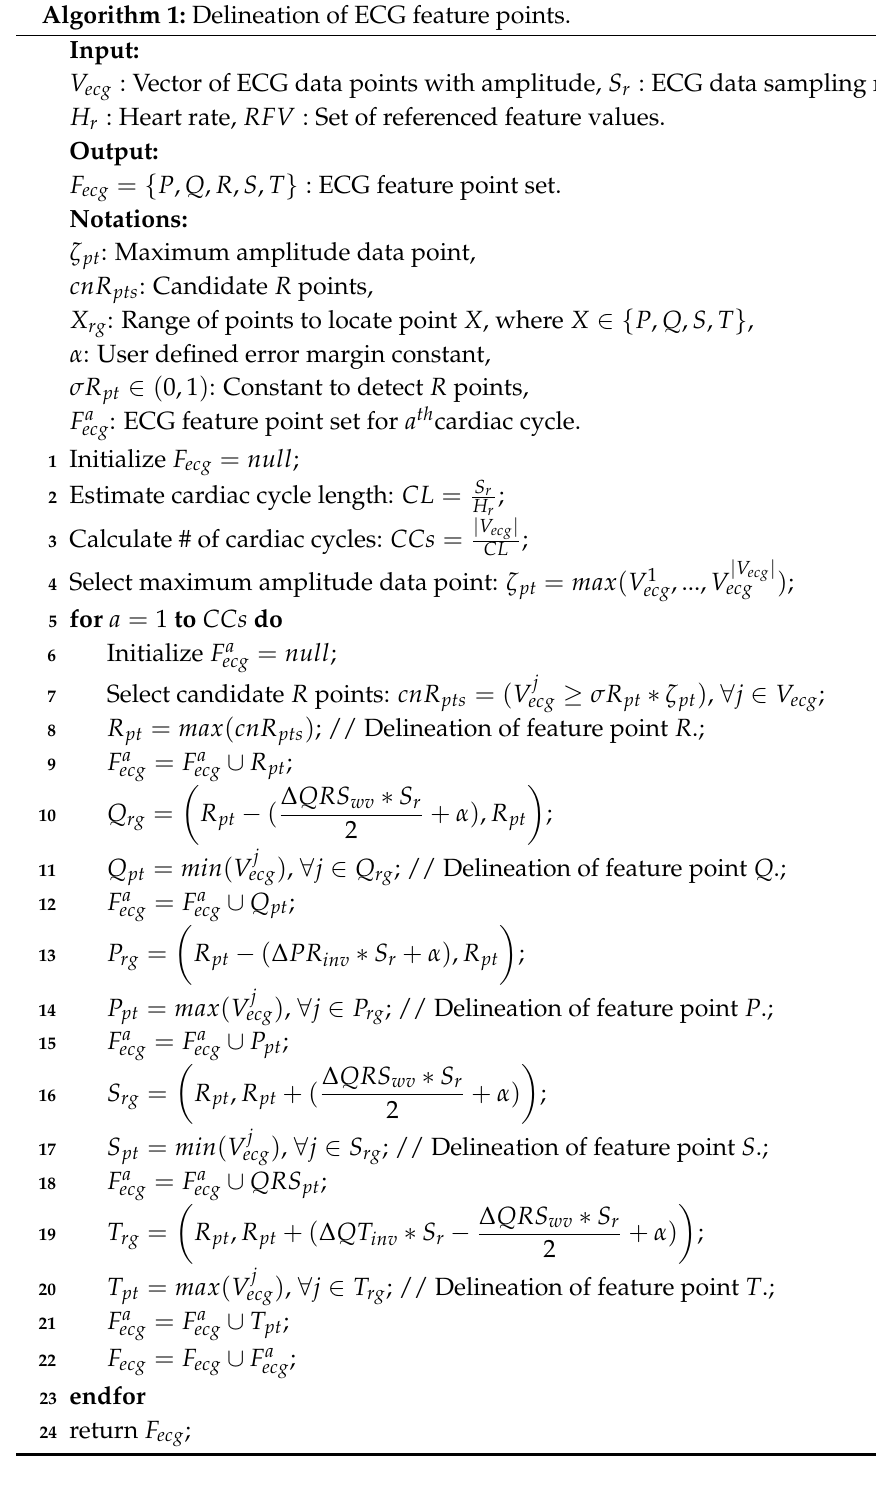
Algorithm 1: Delineation of ECG feature